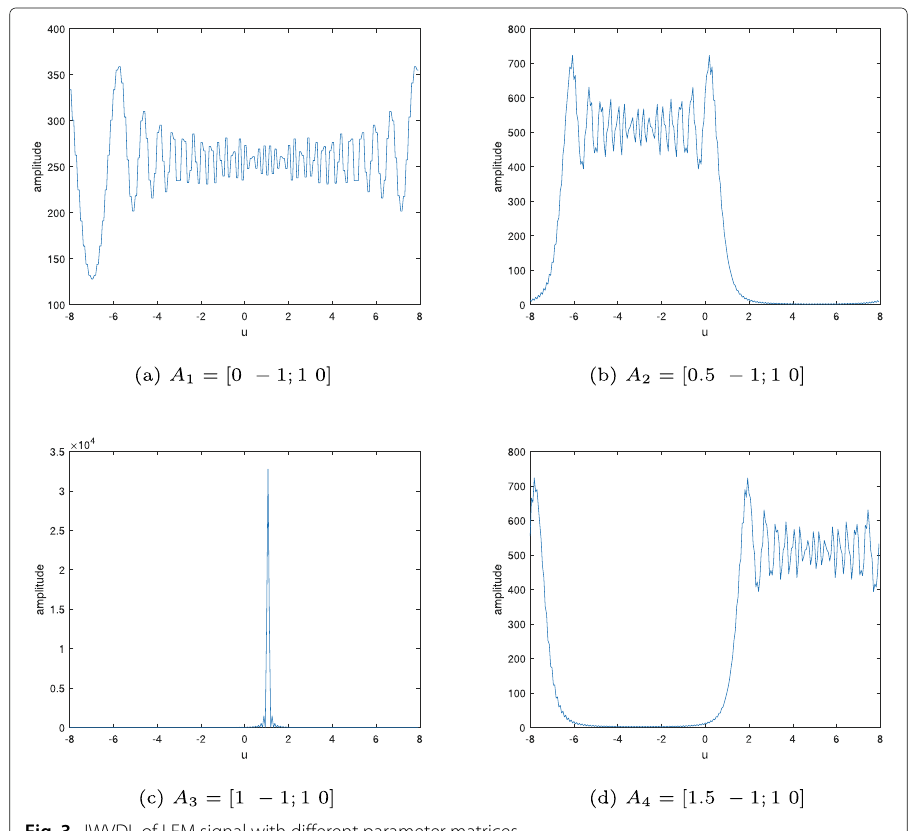
Fig. 3 IWVDL of LFM signal with different parameter